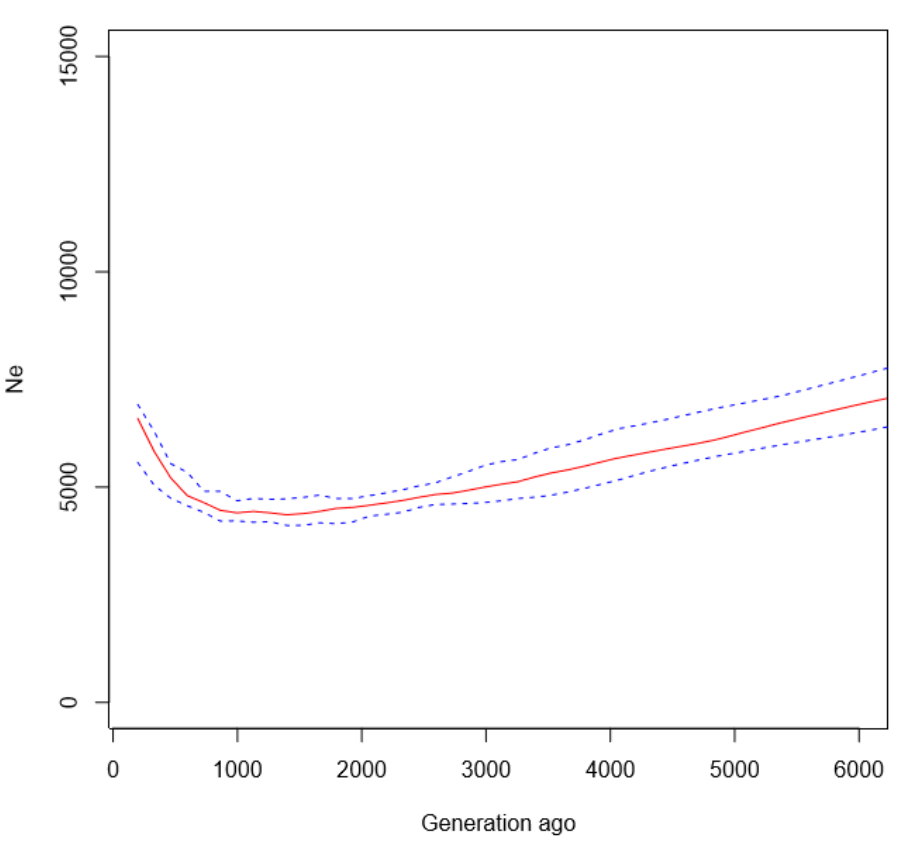
Figure 2. Changes of the effective population size for Lithuanian population. The x -axis shows the time measured in generations (considering that a generation time is 25 years); the y -axis shows effective population size ( Ne ) values as a solid red line and their confidence interval (5th and 95th percentile values) as blue dashed lines.